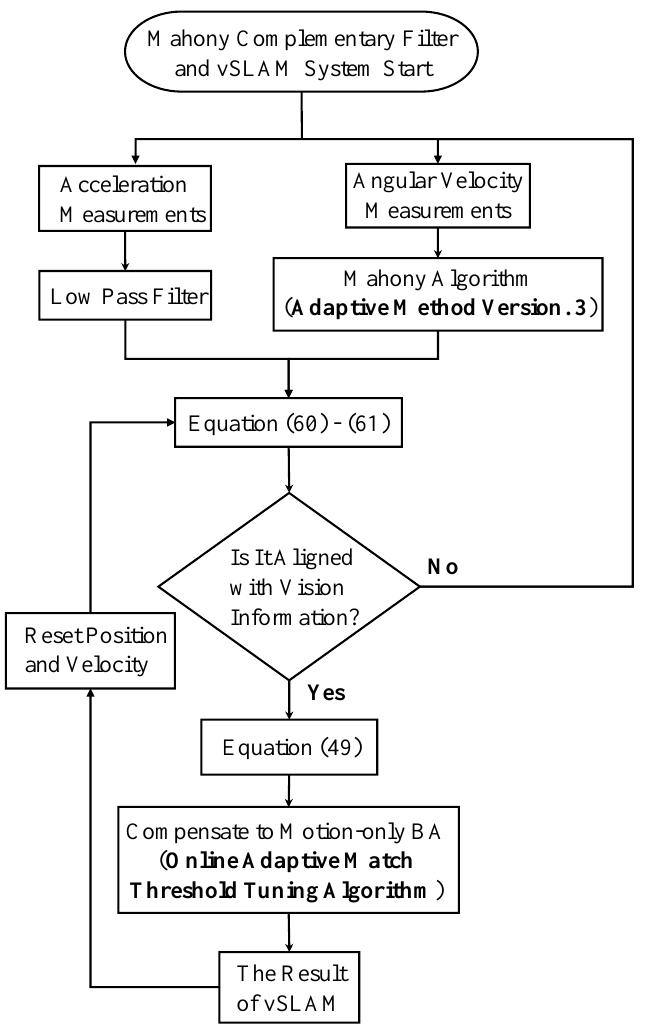
Figure 18. Real-time motion compensation loop subroutine.